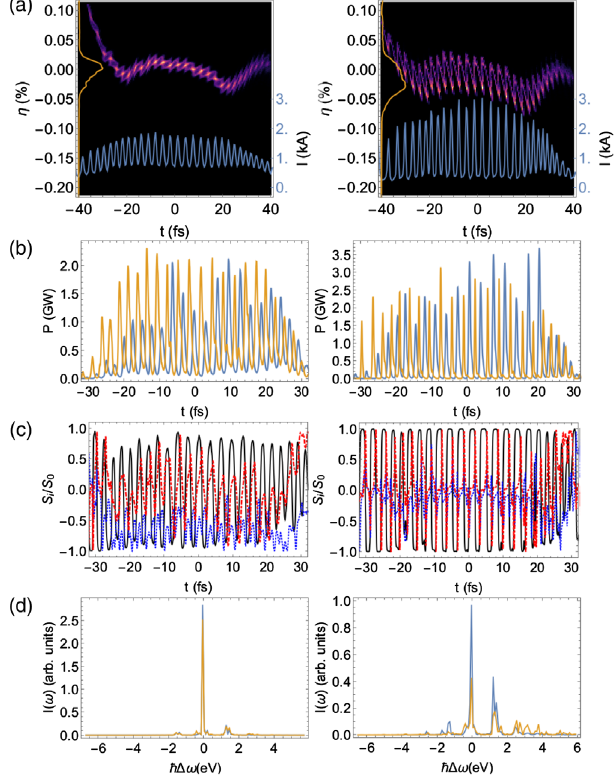
FIG. 9. Left: no X-Leap undulator modulation Right: with X-Leap undulator modulation and R 56 . (a) Longitudinal phase space at undulator entrance with current profile included (blue). (b) Power in s -polarization (blue) and p -polarization (yellow). (c) Normalized Stokes parameters, S 1 =S 0 (black, line), S 2 =S 0 (blue, dotted), S 3 =S 0 (red, dashed). (d) On-axis spectral intensity in s -polarization (blue) and p -polarization